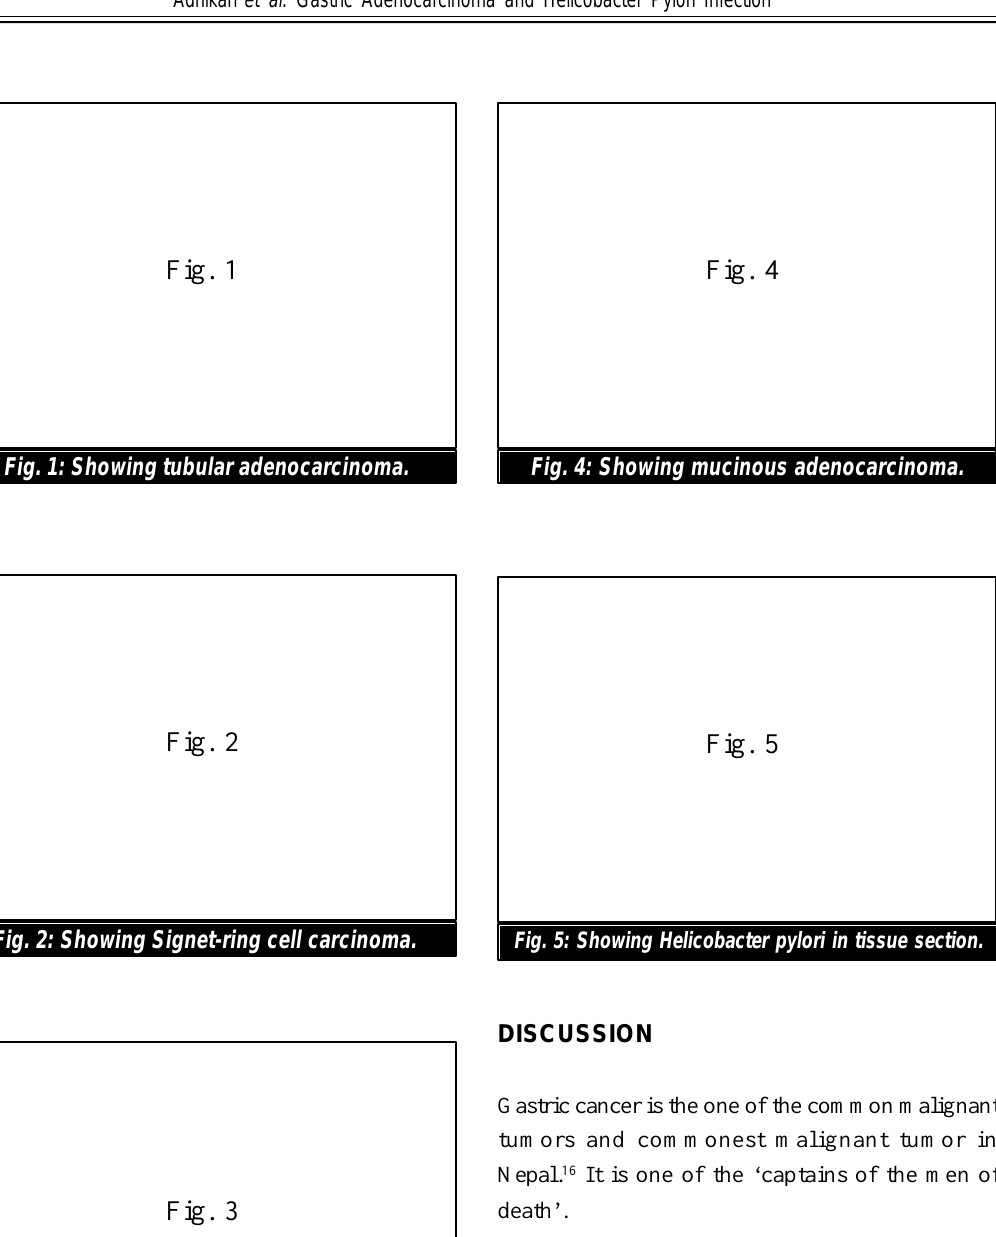
Fig. 5: Showing Helicobacter pylori in tissue